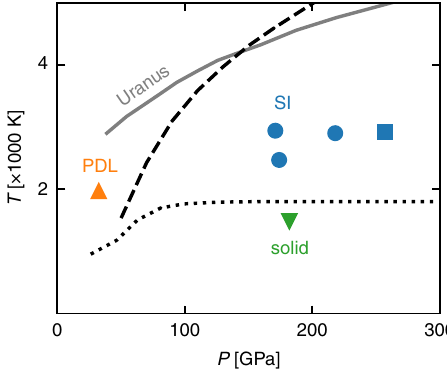
Fig. 1 High-pT phase diagram of water. Shown are the ice-SI (dotted) and SI-PDL curves (dashed), and Uranus ’ isentrope (gray solid). The symbols indicate the pT conditions at which the simulations were